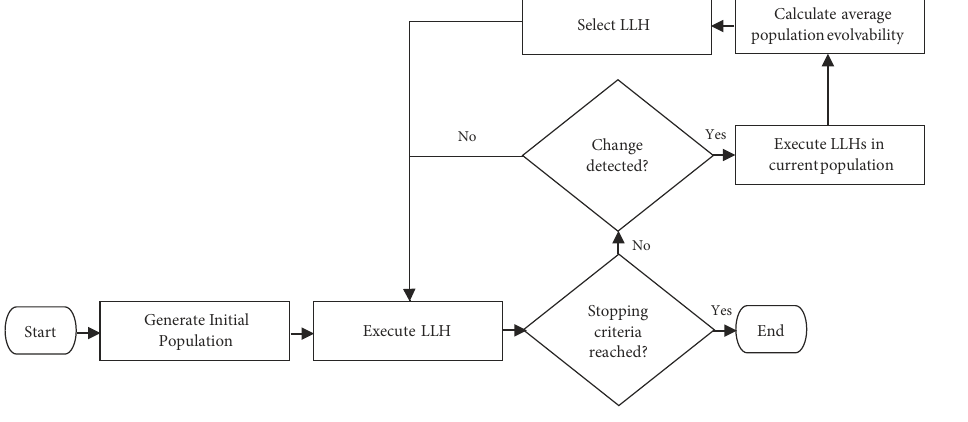
Figure 1. DPEM_HH